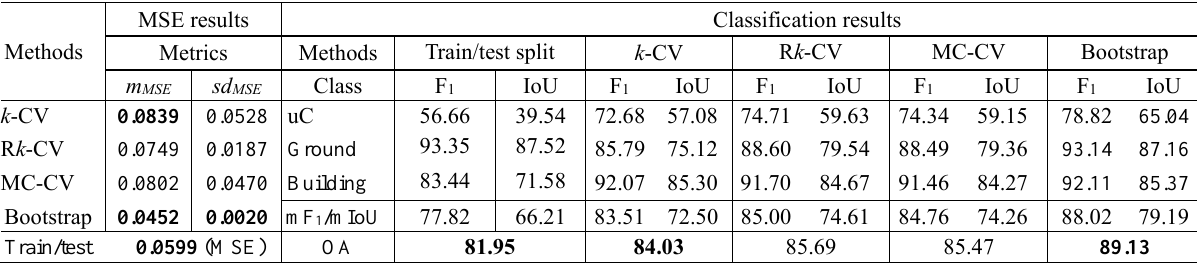
Table 2. Results of train/test split and resampling methods ( k -CV, R k -CV, MC-CV and bootstrap). Results show significant impact on error metrics, and classification performance metrics (in percentage, %) for the AHN test data